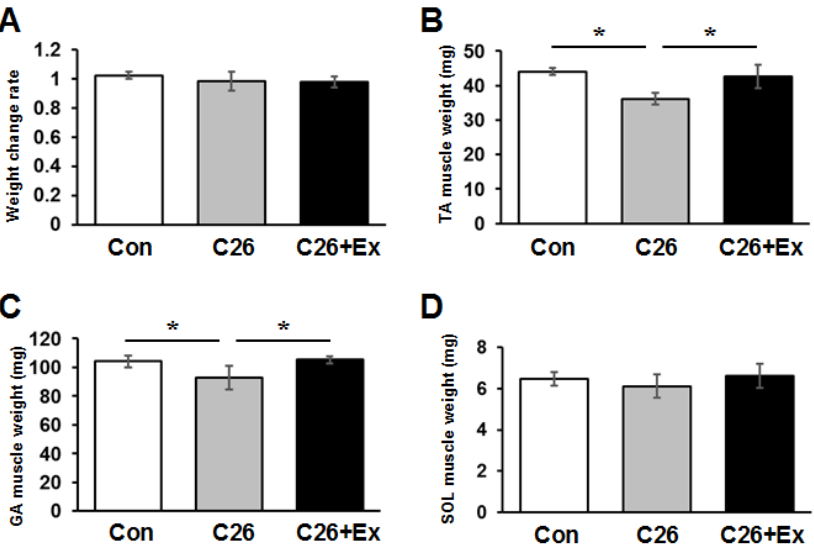
Figure 1. Aerobic exercise suppresses muscle atrophy. Forced running was applied to the cancer-bearing mice for 4 weeks. The ratio of tumor weight subtracted body weight at 4 weeks to the body weight at day 0 is indicated as bar graphs ( A ). Weights of ( B ) TA, ( C ) GA, and ( D ) SOL muscles from control (Con, blank bars), C26 injected (C26, gray bars) and C26 injected and aerobic exercise applied (C26+Ex, dark bars) mice are indicated. The average weight and standard deviation (SD) are indicated. Statistical analysis was carried out with the Kruskal-Wallis test followed by the Mann-Whitney U test. Asterisks: p < 0.05.